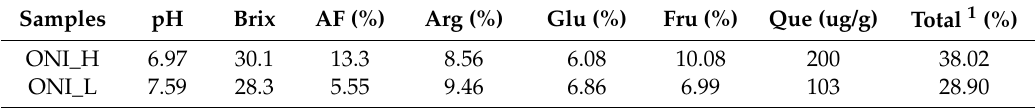
Table 1. The composition of two different onion extracts (ONI_H and ONI_L).